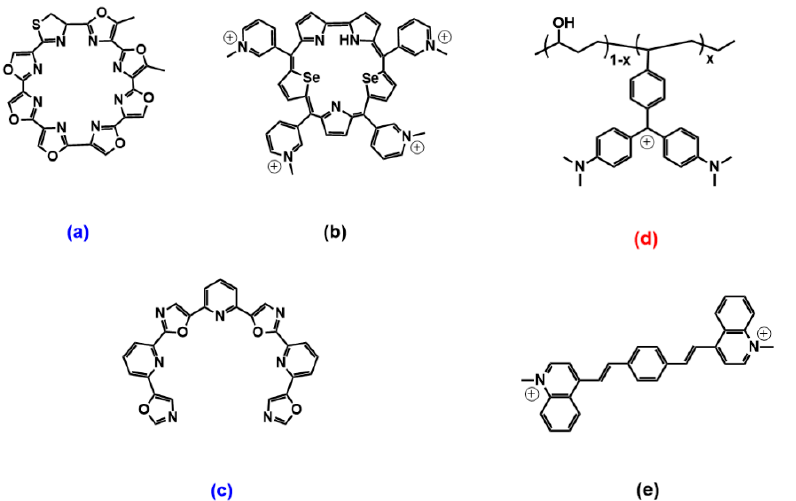
Figure 7. Molecular structures of the other selective G4 binders reviewed here: ( a ) [79], ( b ) [79,80], ( c ) [56], ( d ) [82] and ( e ) [83]. Red letters evidence parallel G4s’ high selectivity, blue letters correspond to molecules selective for antiparallel topology, and the systems with other/mixed behaviour have black lettering.